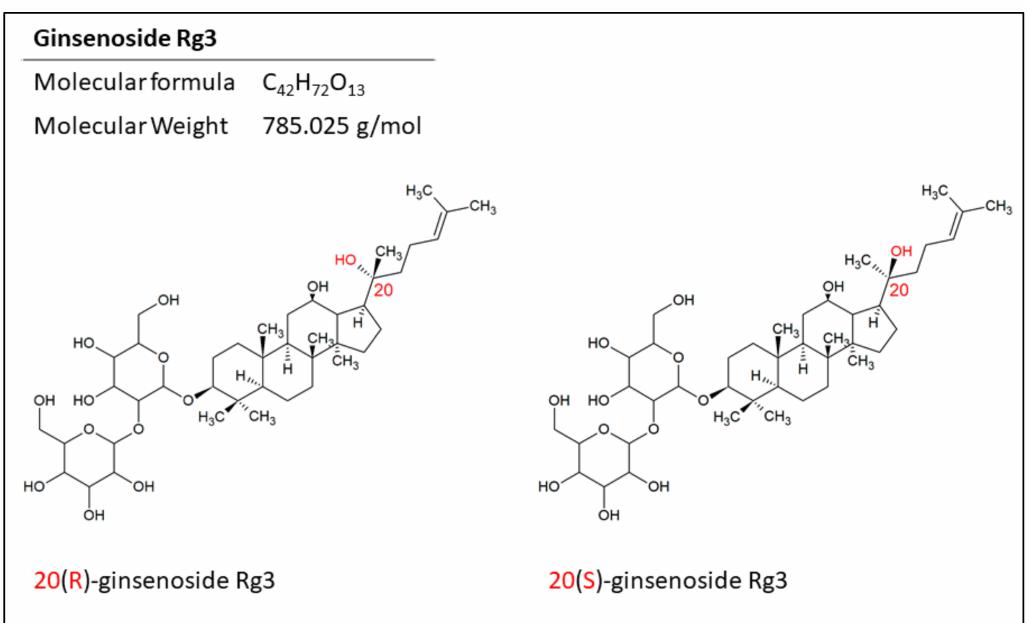
Figure 2. The structure of the epimers of ginsenoside Rg3. The position of the hydrogen on C 20 makes two epimers for this